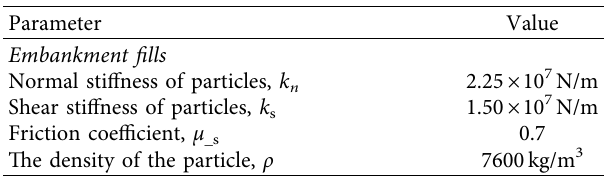
Figure 3: Calibration of embankment fills: (a) curves of the deviatoric stress versus the axial strain and (b) the internal friction angle of the embankment fills. Table 1: Micromechanical properties.